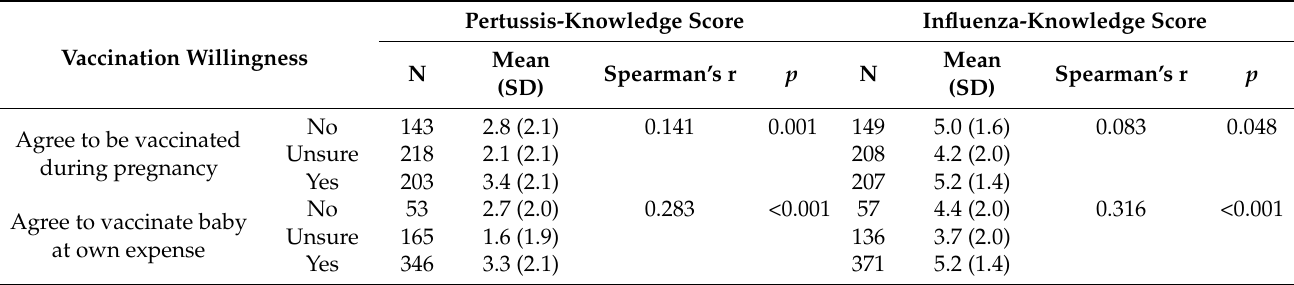
Table 4. Correlation between knowledge scores and vaccination